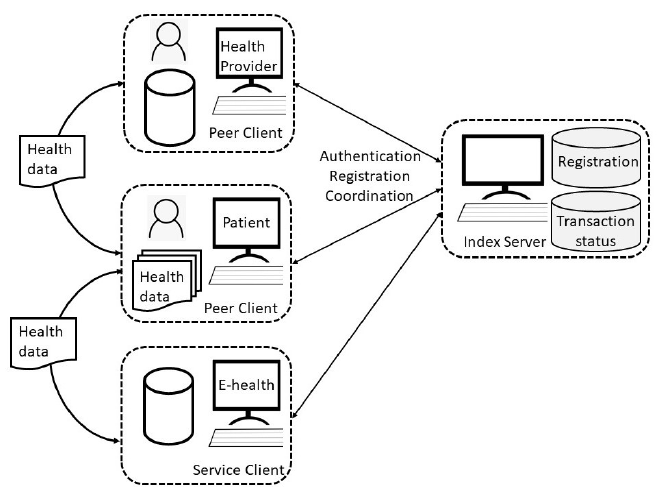
Figure 1. System